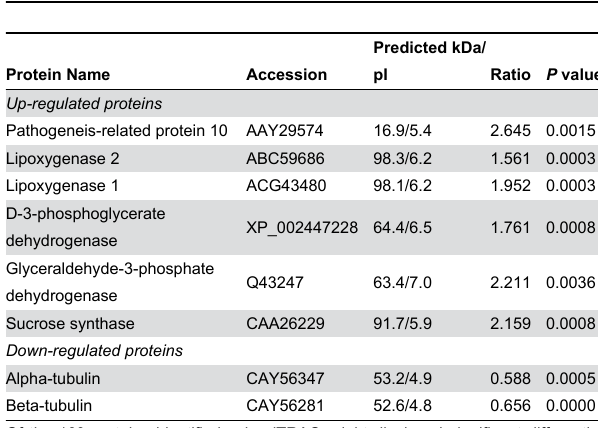
Table 3. Proteins differentially regulated in response to 48 h of ECB feeding